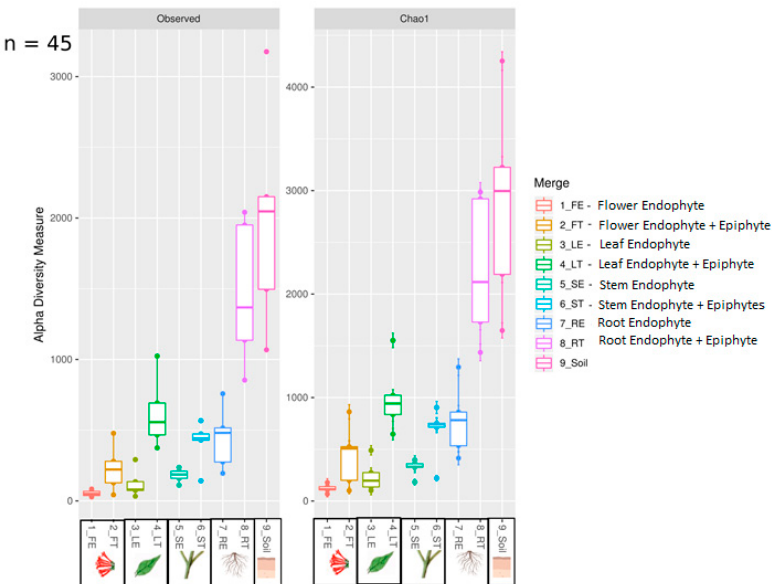
Figure 2. Boxplot showing observed and Chao1 alpha diversity indexes. Samples were grouped by anatomical parts of the plant of endophyte and endophytes+epiphytes and soil bacterial samples.